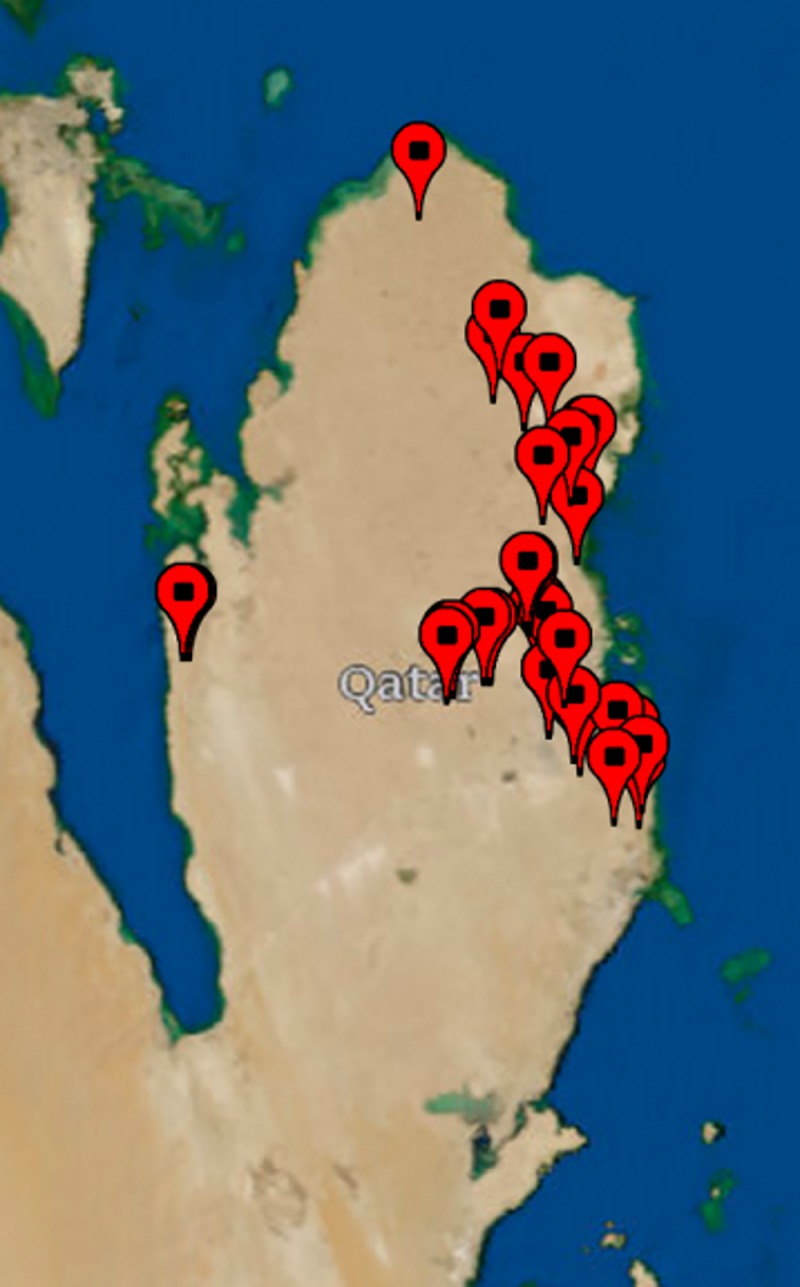
GPS locations of 55 date palm trees from which leaves have been collected in the State of Qatar.Collection sites around the Eastern coast line are representative for municipalities in which date palm trees are grown. Few trees are found in the Western part of Qatar and in the desert region to the South. Map was created using U.S. Geological Survey (USGS) Topological Imagery as a base map in MATLAB (The Mathworks, Natick, USA).